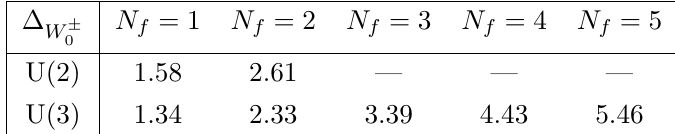
Table 12 . The IR R -charge of the monopole operator W ± the monopole superpotential. Again the values for U(2) with N is